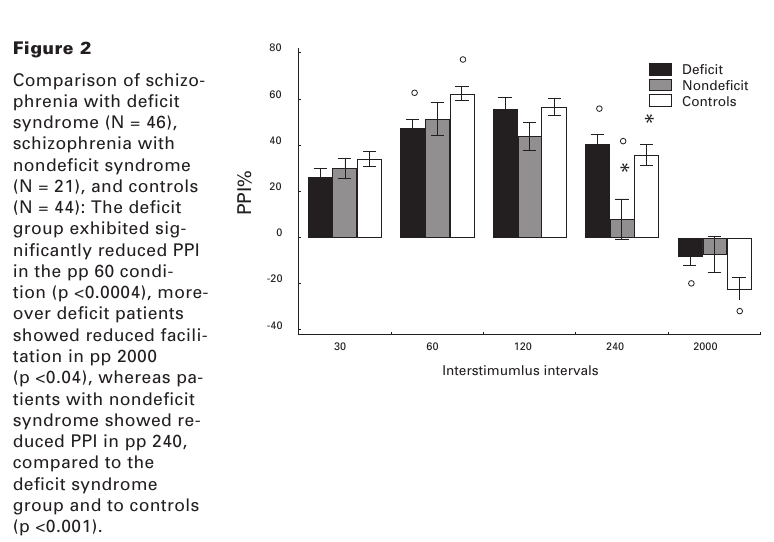
phrenia patients (N = 67) and controls (N = 44): Schizophre- nia patients showed a significant PPI deficit in the pp 60 ms condition compared to controls (p <0.004) and a reducted facilita- tion in the pp 2000 ms condition (p <0.02).